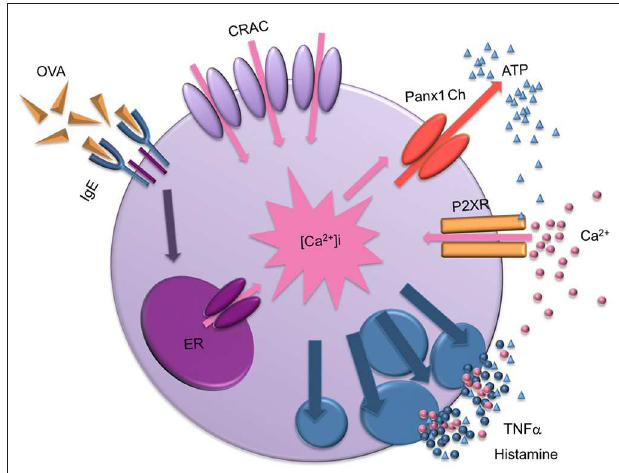
FIGURE 6 | Scheme of the mast cell degranulation process induced by IgE cross-linking and the involvement of Panx1 channels. After antigen recognition, biochemical events lead to Ca 2 + release from intracellular stores likely to be the endoplasmic reticulum (ER), causing a transient increase in cytoplasmic Ca 2 + concentration ([Ca 2 + ] i ). Then, Ca 2 + released from the ER activates the Ca 2 + influx through membrane channels (calcium released activates CRAC channels) slowly replenishing intracellular stores. Sustained increase in Ca 2 + signal also favors the transient opening of Panx1 Chs, allowing the release of ATP to the extracellular media and activation of purinergic receptors (P2XRs). Active P2XRs contribute to the sustained increase of [Ca 2 + ] i , promoting activation of Panx1 Chs and mast cell degranulation, leading to release of pro-inflammatory compound such as TNF- α and histamine. Finally, high extracellular ATP concentration could block Panx1